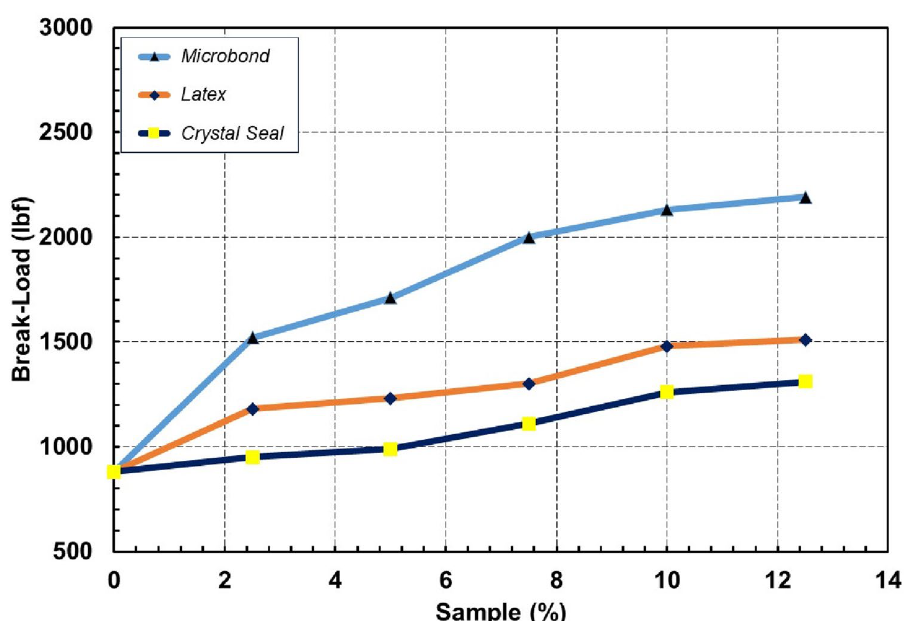
Fig. 18 Additives comparison,